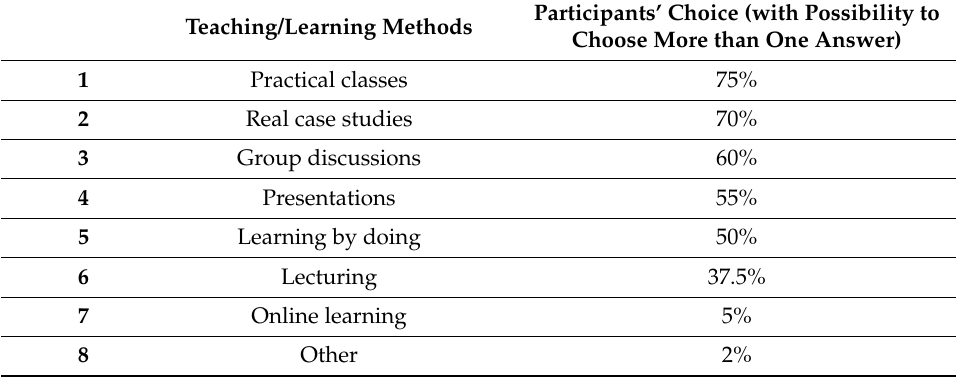
Table 1. ANAU students’ teaching/learning method preferences (based on the online